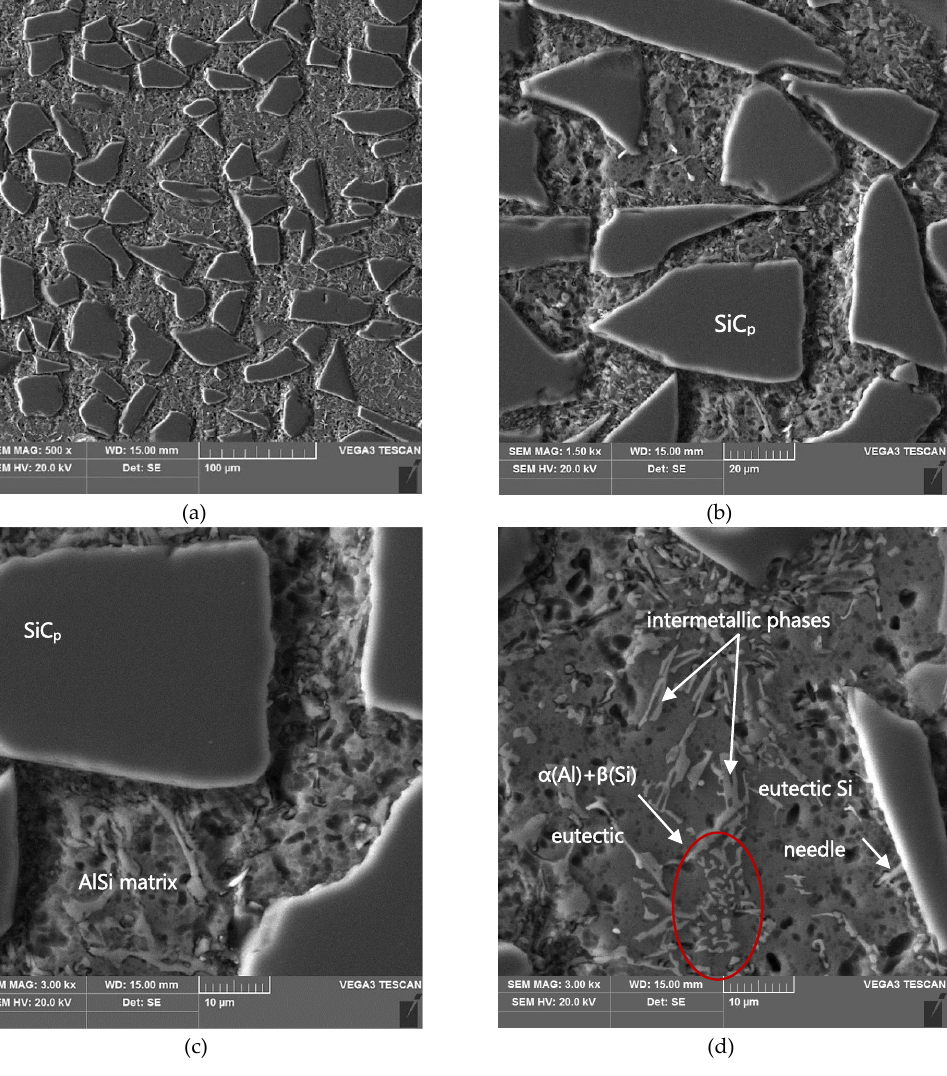
Figure 7. ( a – d ) SEM microstructure in the area of formed AlSi12/SiC p composite layer; section etched in 20% NaOH solution for 60 s (deep etching).